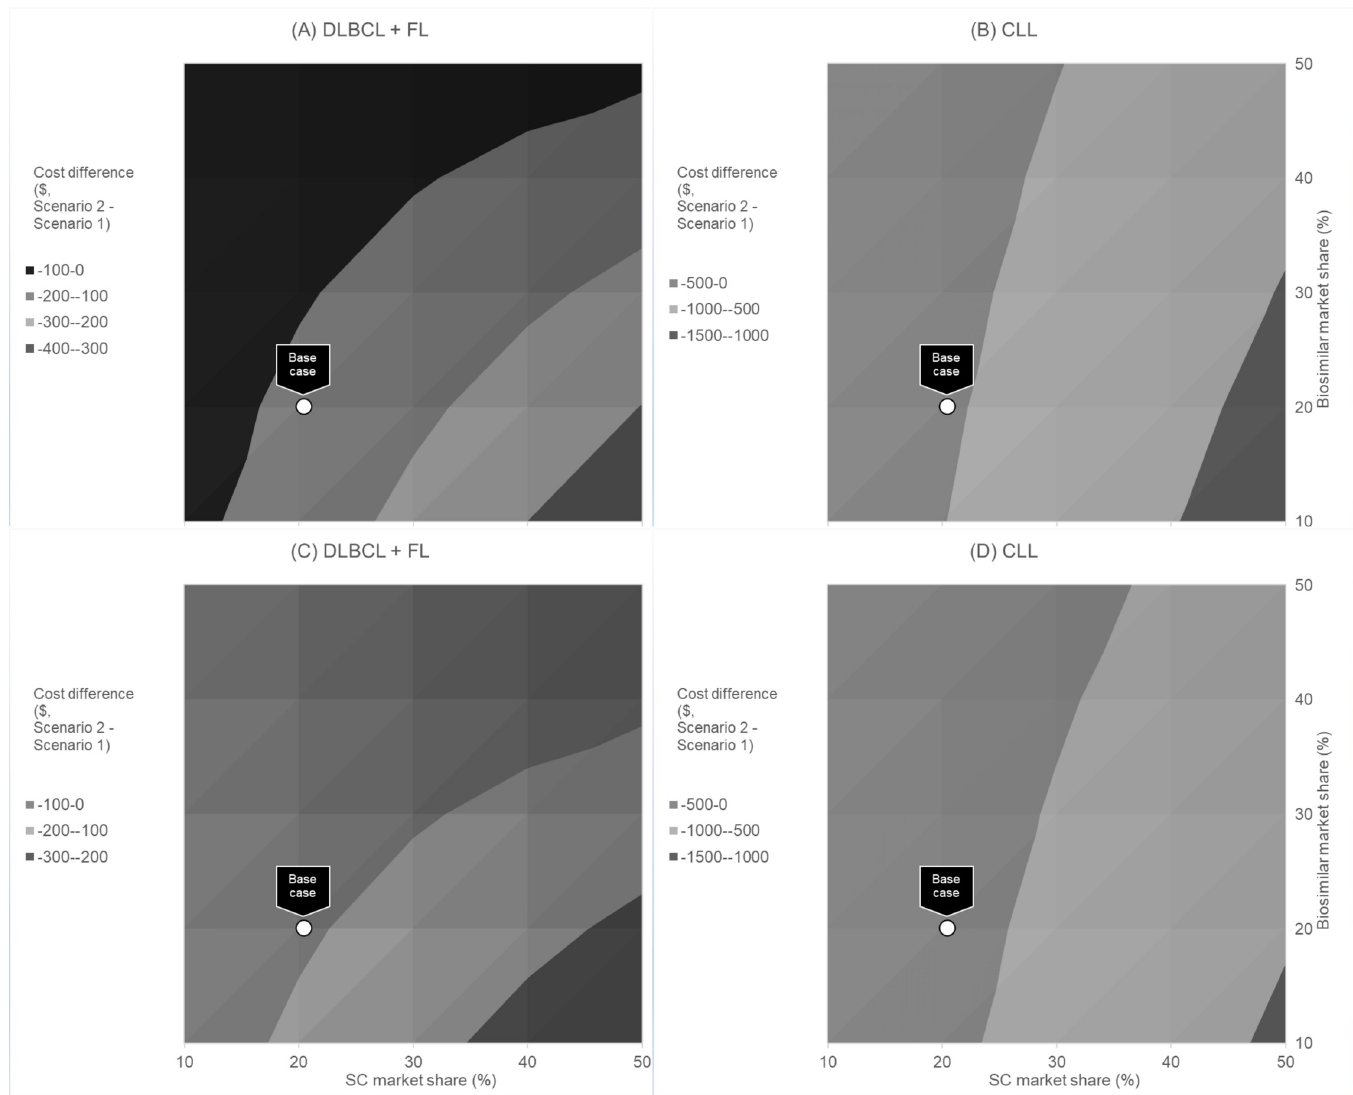
Fig 5. Expected cost savings given market share shift in SC and biosimilar IV, per indication, per